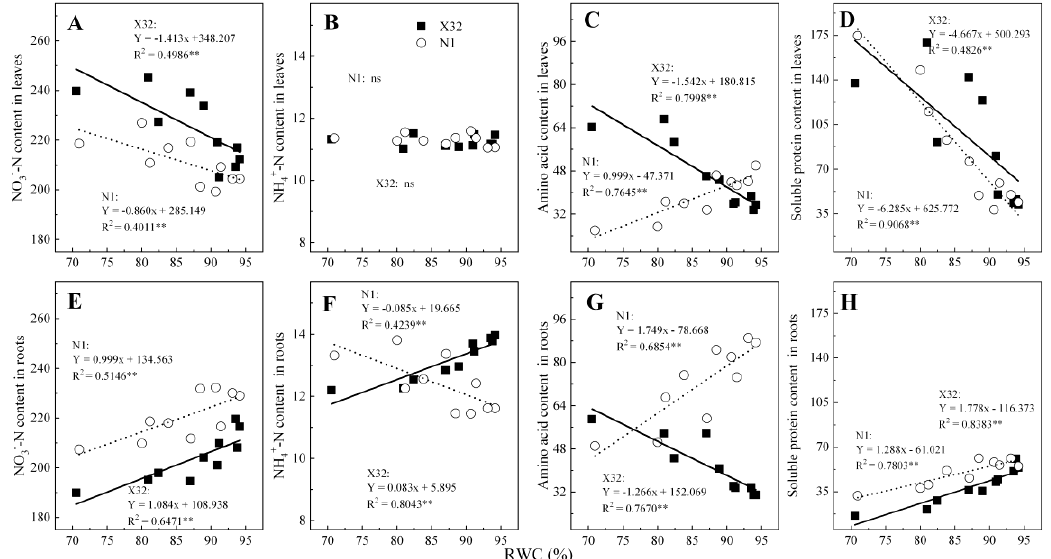
Figure 9. Relationship between NO 3 − -N, NH 4+ -N, amino acid or the soluble protein content with leaf relative water content in leaves ( A – D ) and roots ( E – H ) for the two sweet potatoes. The solid and dotted lines represent X32 and N1, respectively.